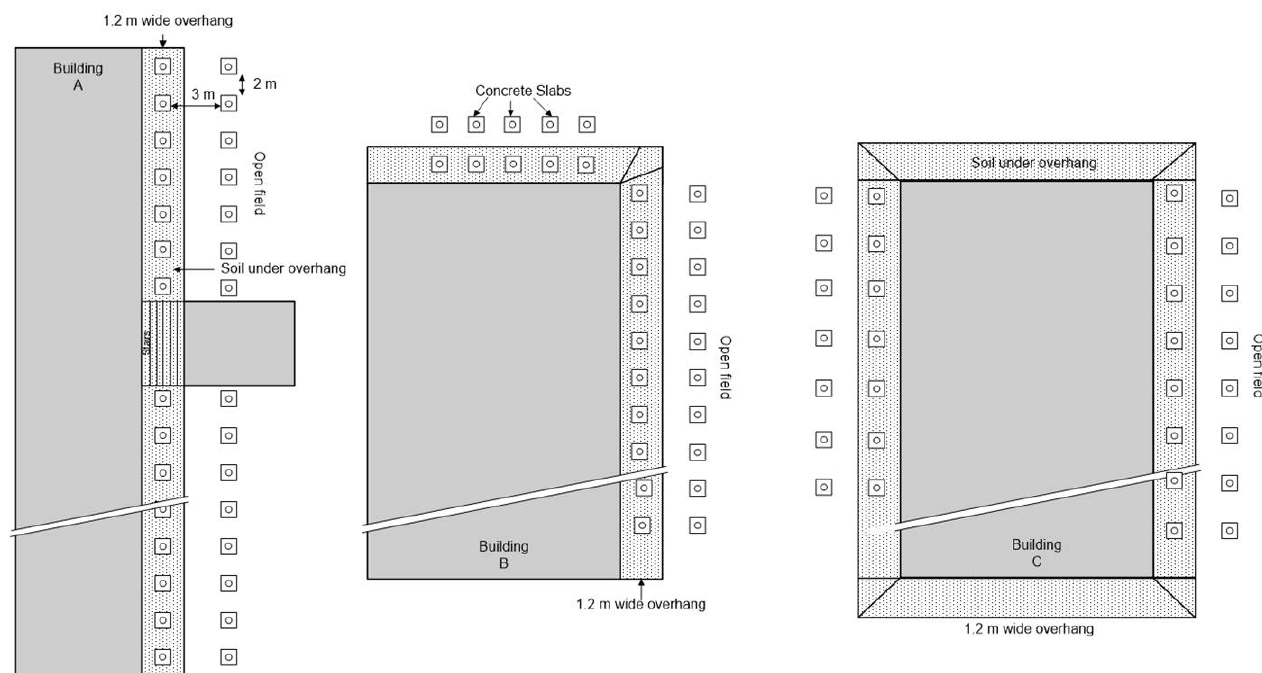
Fig 2 . Schematic position of concrete slabs in three field sites used for cypermethrin in open field and under roof overhang.